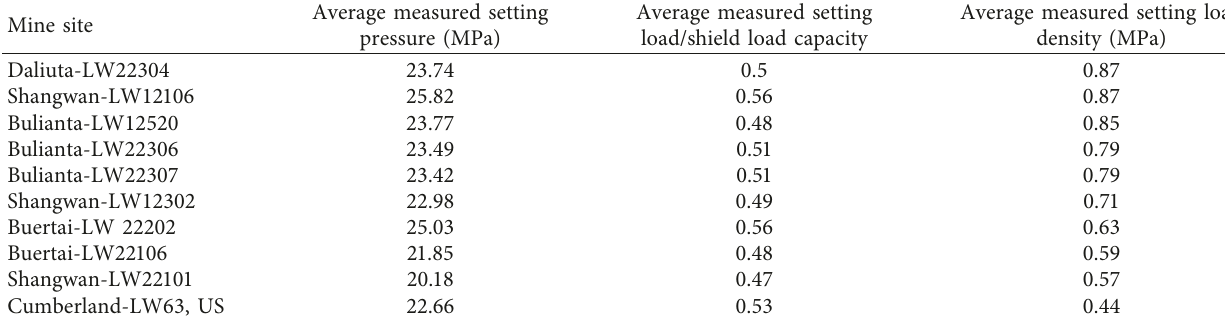
Table 3: The averaged values of setting pressure for 10 longwall